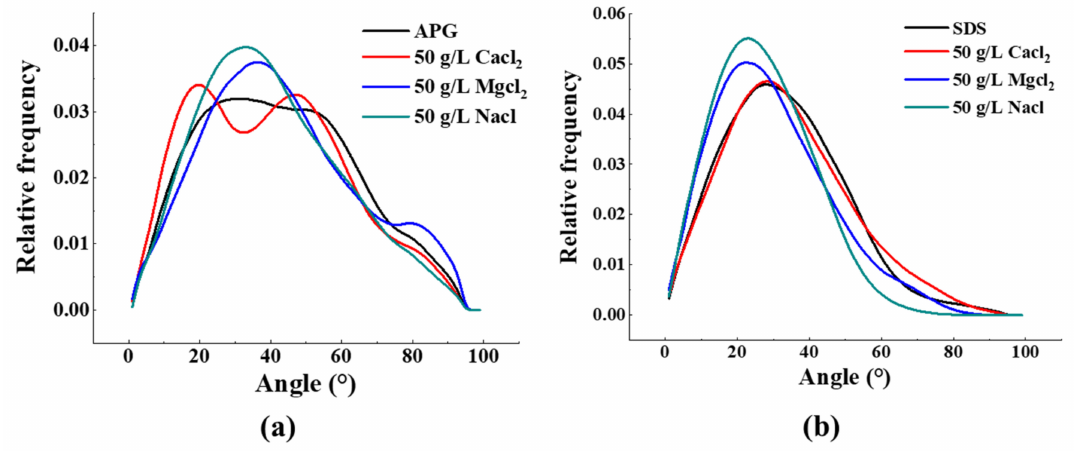
Figure 17. Distribution of θ head in different foams. ( a ) APG foam system, ( b ) SDS foam